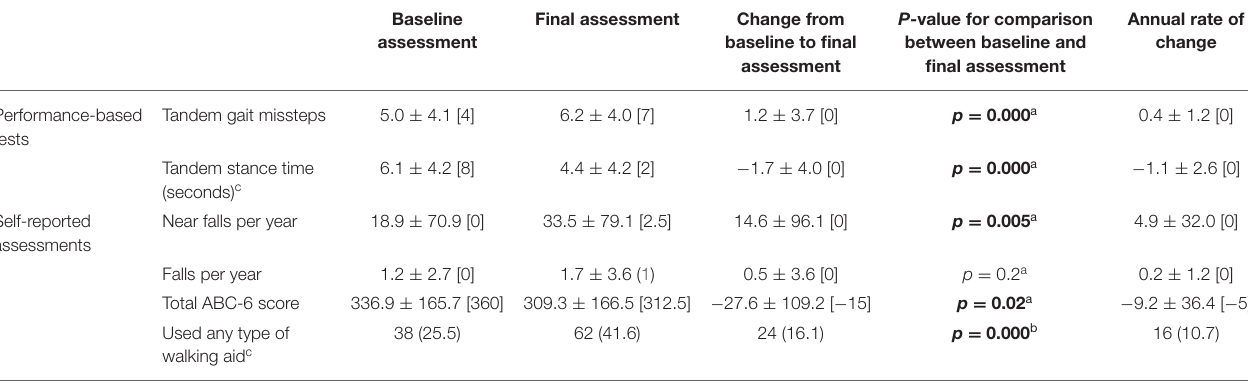
TABLE 2 | Gait and balance characteristics of ET participants.